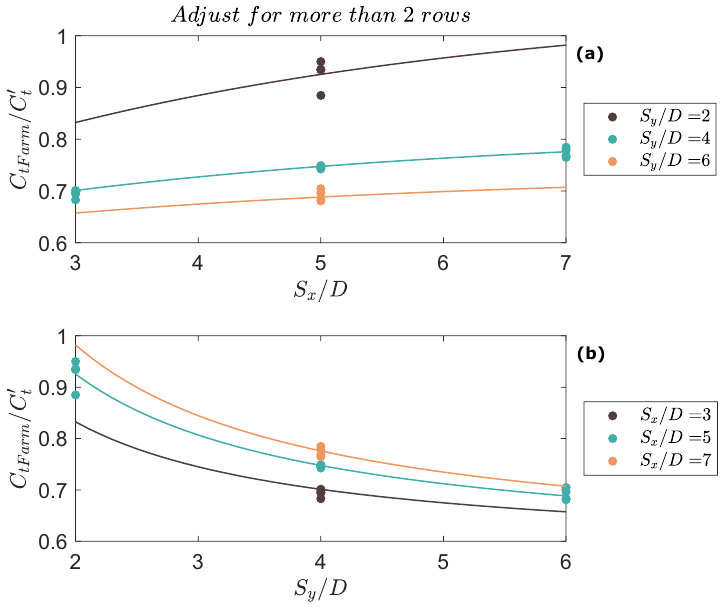
Figure 10. C tFarm / C ′ t , for farms with more than two rows of turbines, versus the disks separation in: ( a ) the streamwise direction, and ( b ) in the spanwise direction. Continuous line: Empirical solution proposed in Equation (9). Dots: Results from DES numerical